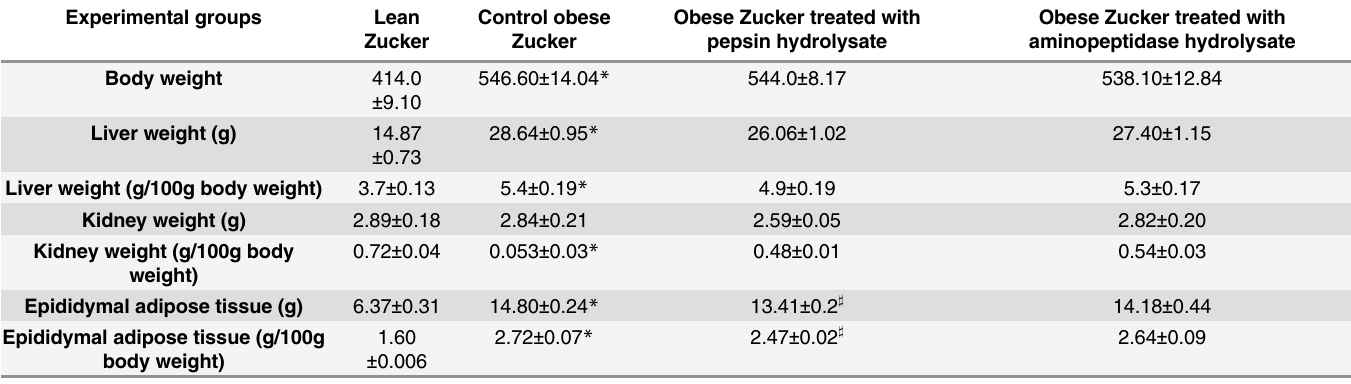
Table 2. Body and organs weight at the end of the study period of lean Zucker rats, obese Zucker rats that received water (control), and obese Zucker rats that received 750 mg/kg/day of pepsin and aminopeptidase egg white hydrolysates for 12 weeks. Values are means ± SEM (n = 10). Experimental groups Lean